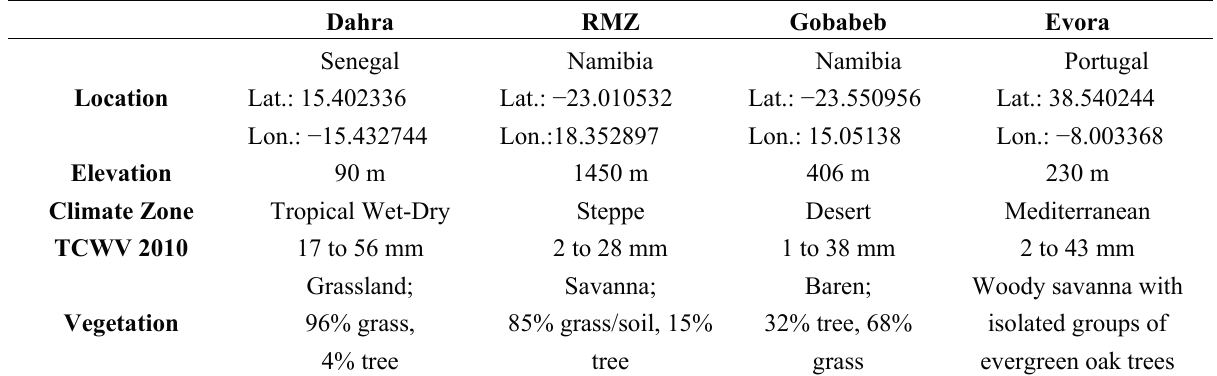
Table 1. Overview of KITs validation stations. TCWV, total column water